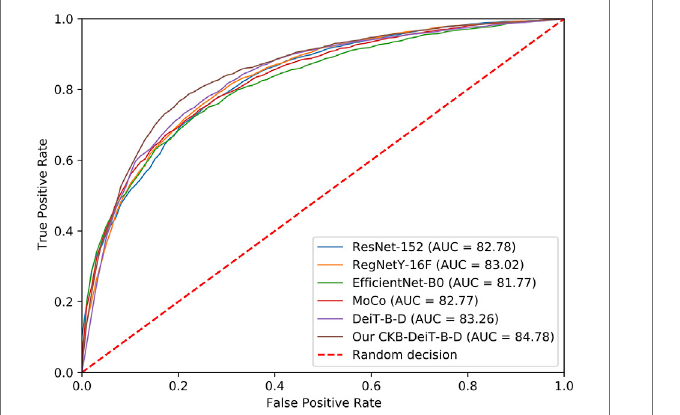
FIGURE 6 | ROC curves of different methods for the DFU ischaemia classi fi